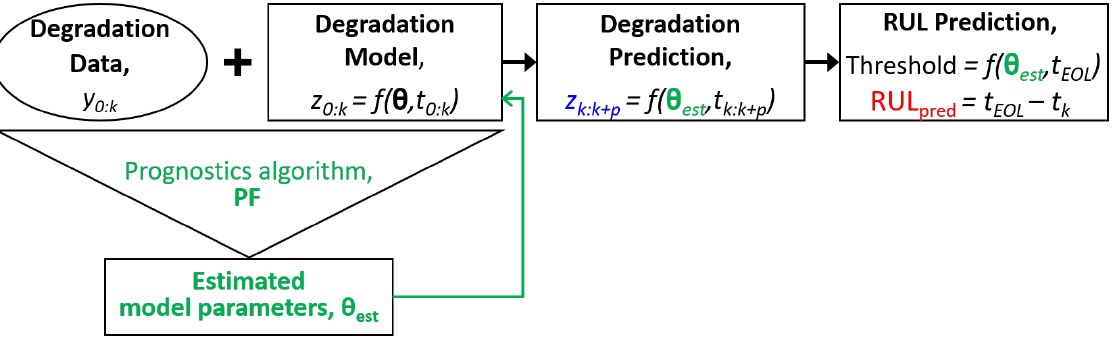
Figure 2. Flow chart of the prognostics process.